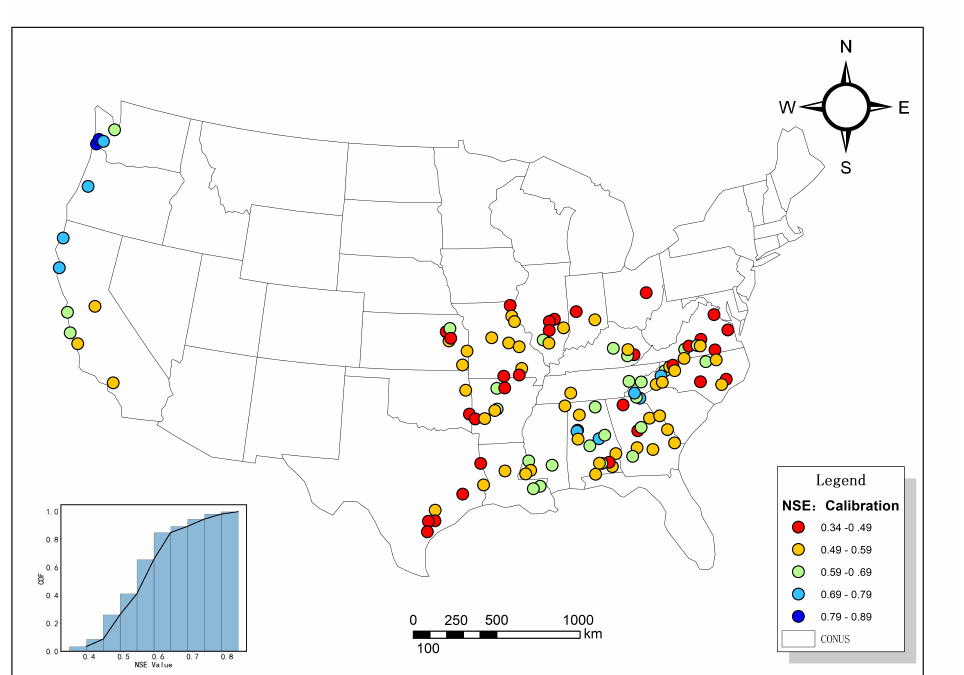
Figure 2. Nash–Sutcliffe model efficiency coefficient (NSE) of 196 catchments in CAMELS data set averaged over calibration period.